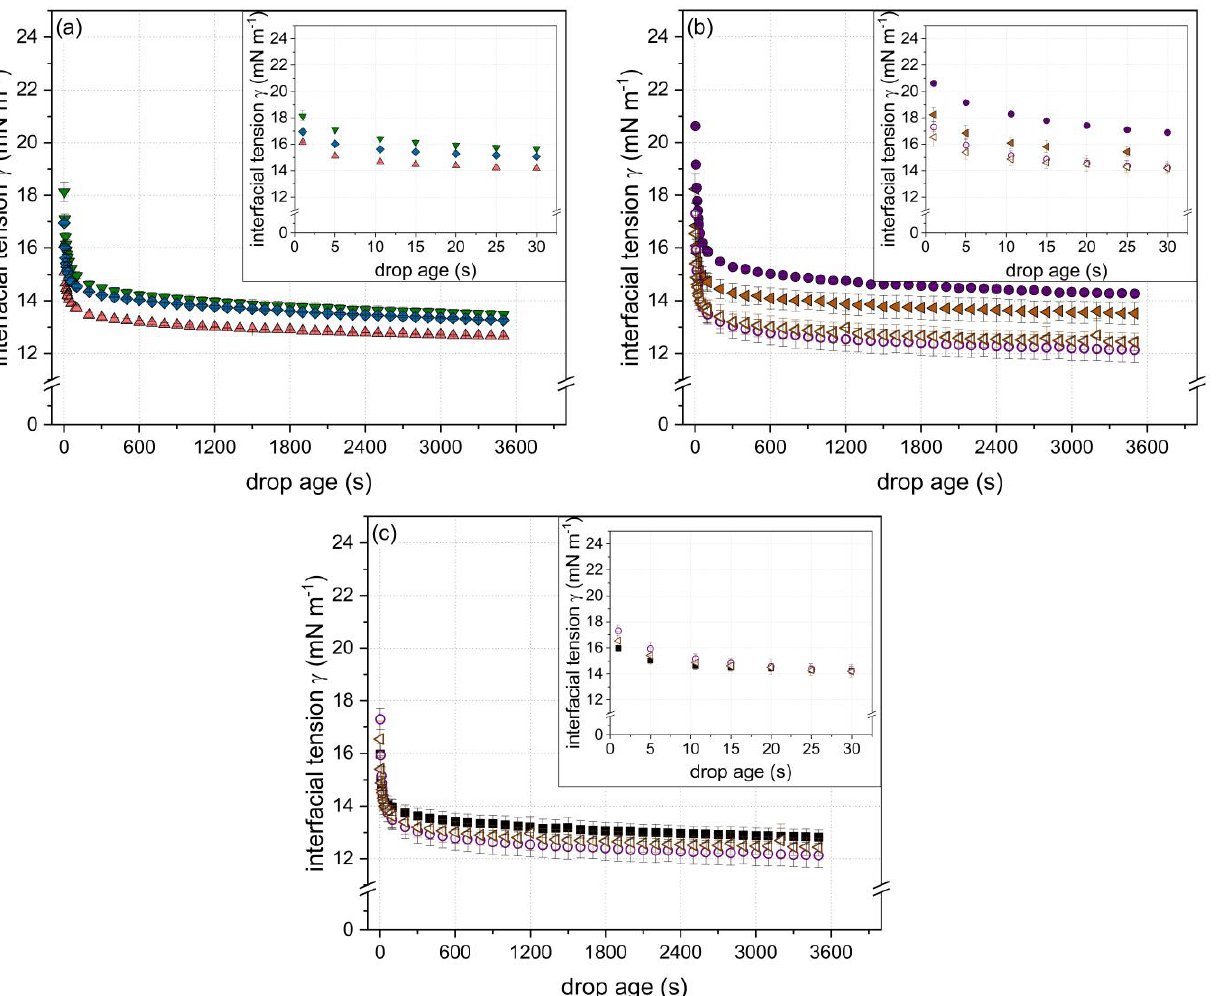
Figure 5. Evolution of interfacial tension (γ) in dependence of time as a function of the β -Lg particle (c = 8.2 g L − 1 ) physicochemical properties: ( a ) varying degree of cross-linking ( ▼ 85, ▲ 92, and ◆ 109%) but similar size (~22 nm) and similar zeta potential (~ − 30 mV); ( b ) varying net zeta potential ( ● -38 and ○ -30 mV or ◀ − 35 and ◁ − 29 mV, respectively) but similar size ( ● / ○ ~120 and ◀ / ◁ ~42 nm, respectively) and similar degree of cross-linking (~105%); ( c ) varying particle size ( ■ 3, ◁ 40, and ○ 119 nm) and degree of cross-linking ( ■ 120 and ◁ / ○ ~105%) but a similar zeta potential of ~ − 30 mV. Error bars indicate standard deviation.